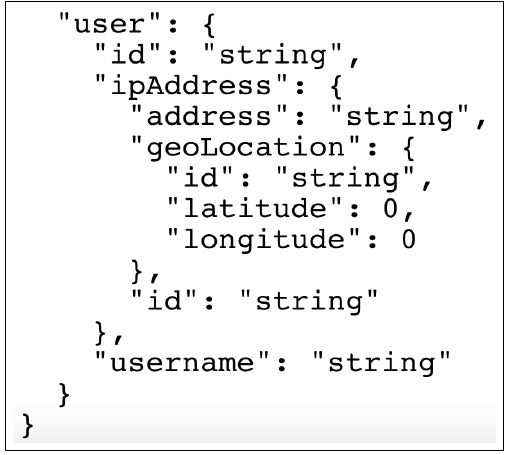
Figure 3. Example data required by the AppSensor API.